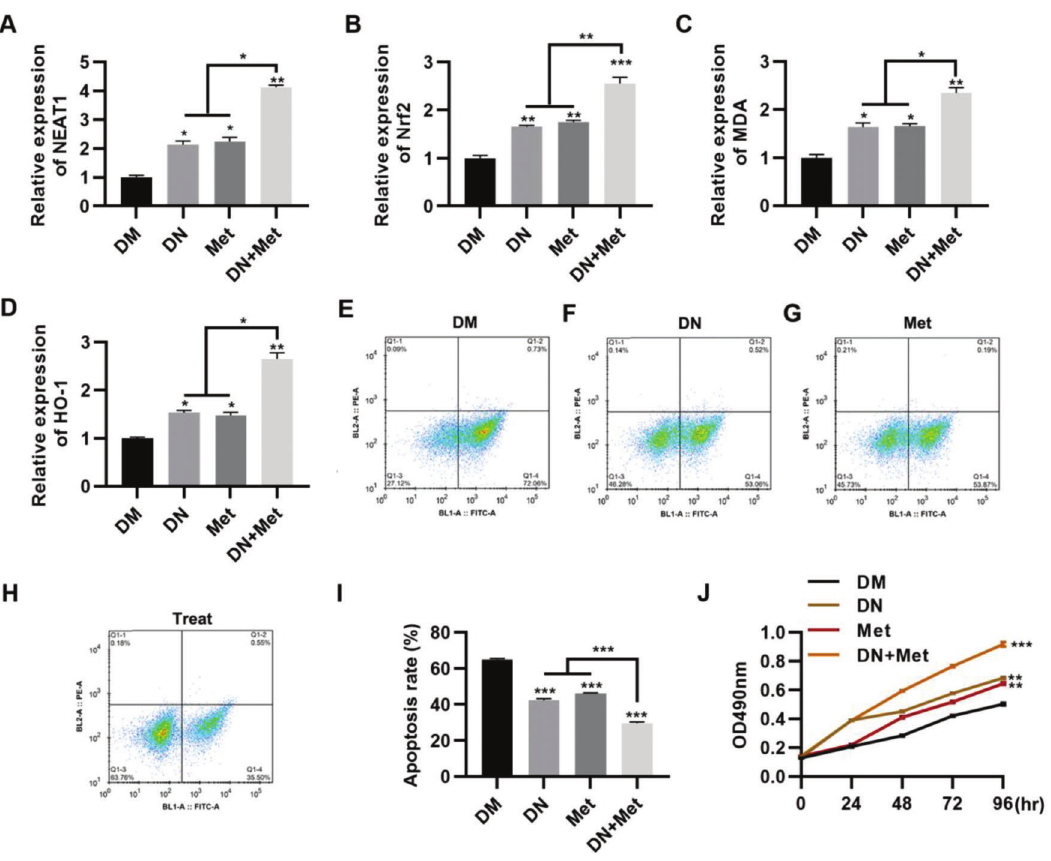
Figure 2 - NEAT1 expression in H9c2 cells maintained in high-glucose medium is upregulated by combination treatment with dendrobium mixture and metformin, which was accompanied by a significant decrease in apoptosis. A-D, The combination of dendrobium mixture (DN) and metformin (Met) promoted the expression of NEAT1 and Nrf2 pathway-related genes in H9c2 cells maintained in high-glucose (HG) medium. The combination of dendrobium mixture and Met inhibited apoptosis (E-I) and promoted the proliferation (J) of H9c2 cells maintained in HG medium. * p o 0.05, ** p o 0.01, *** p o 0.001, Kruskal-Wallis test followed by Dunn ’ s multiple comparisons test (A-I), Mann-Whitney U test